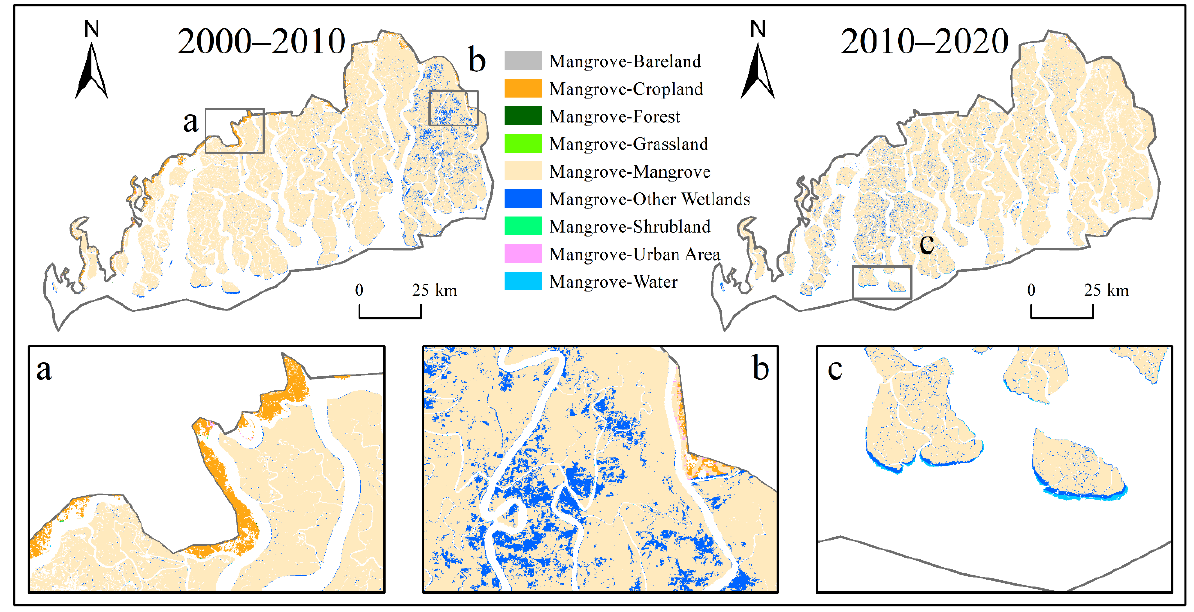
Figure 11. Maps of spatial–temporal distribution of mangrove degradation in the Sundarban from 2000 to 2020. ( a ) first degradation detail picture; ( b ) second degradation detail picture; ( c ) third degradation detail picture.